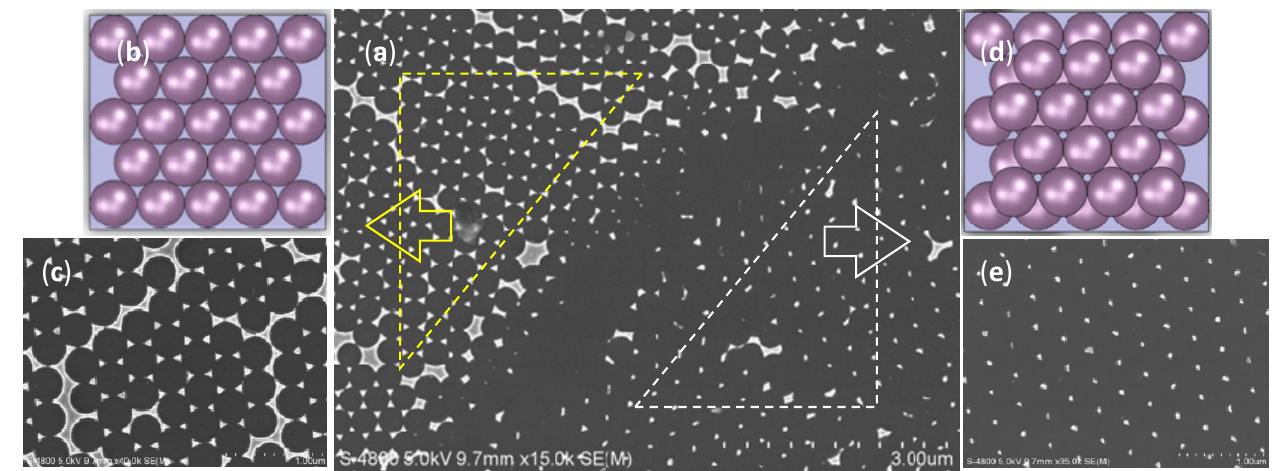
Figure 3. ( a ) SEM image of gold nanoparticles arrays template-fabricated by monolayer and bilayer PS microspheres array template on the same substrate; ( b ) Monolayer PS microspheres array template; ( c ) Gold nanoparticles arrays fabricated by the template as ( b ); ( d ) Bilayer PS microspheres array template; ( e ) Gold nanoparticles arrays fabricated by the template as ( d ).